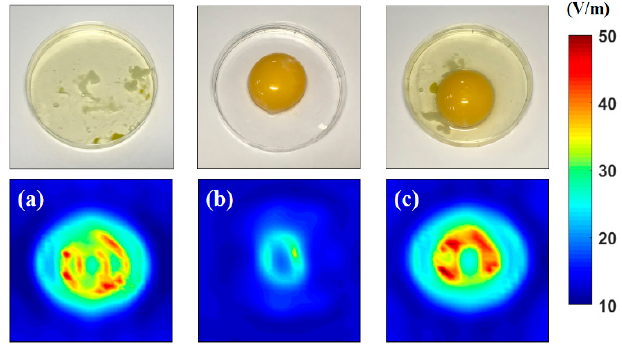
Figure 9. Microwave images of ( a ) only albumen, ( b ) only yolk, and ( c ) the combination of albumen and yolk (all of the microwave images were scanned at 10.4 GHz).